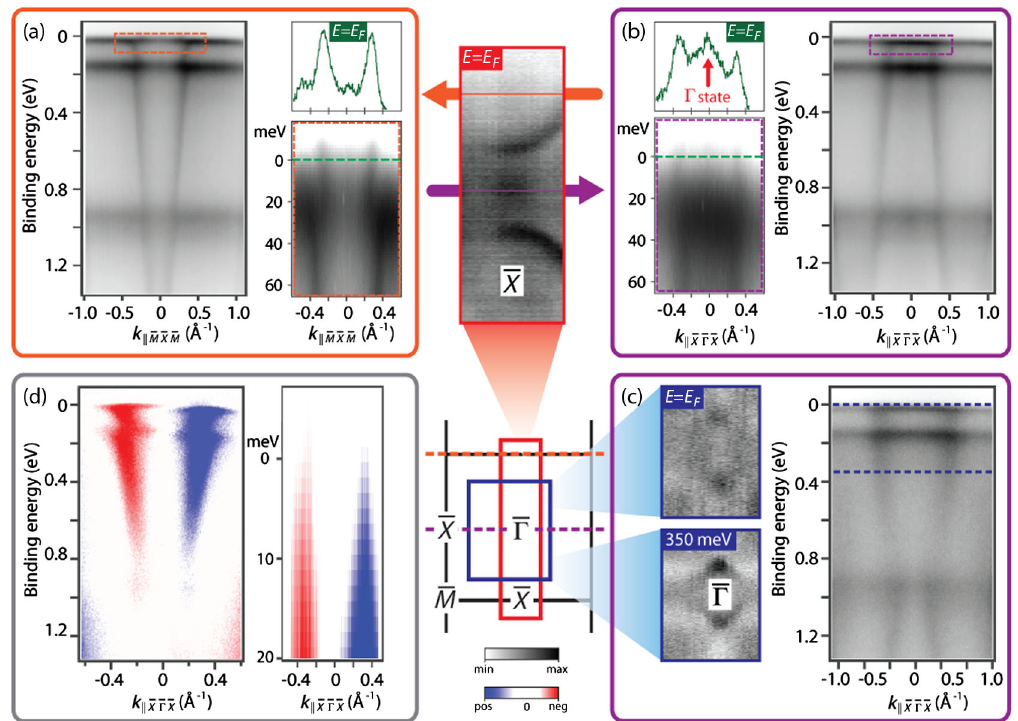
FIG. 3. Energy dispersion and dichroic signature of the X state and identification of an additional (cid:1) -state feature. (a),(b) Data recorded for k z ¼ 6 (cid:2)=a ( h(cid:1) ¼ 70 eV ) for the k -space cuts along the MXM and X (cid:1) X high-symmetry directions as indicated by the color-coded arrows underlying the Fermi-surface map in between the panels (integrated over (cid:3) 5 meV ). In each case, a zoom of the dashed region is included, as is a momentum-distribution line cut in green for E ¼ E F . In (a), the zoom panel clearly shows the X states crossing E F , and the same states seen as the outer two features in (b) are joined by an enigmatic, third feature centered on the zone center dubbed the (cid:1) state. (c) Data along the same direction as that in (b) but now recorded for k z ¼ 4 : 5 (cid:2)=a ( h(cid:1) ¼ 34 eV ). It is evident that these Sm 5 d -dominated states now have an inverted dispersion with respect to (b). Plus, both the Fermi surface and the (cid:2)(cid:1) 350-meV energy contour (both integrated over (cid:3) 10 meV ) possess significant intensity around the point, rather than centered on (cid:2) X the point. A schematic of the surface Brillouin zone is added between (c) and (d), showing the color-coded k -space coverage of the constant-energy surfaces and the k -space trajectories, giving the E ð k Þ images as dashed lines. Finally, (d) illustrates the dichroic signature of the Sm 5 d -related bands, shown for different binding-energy regimes and k z values. Plotted is the difference in ARPES intensity between data recorded using left or right circular light. It is clear that this dichroic signal has the same sign at all energies below 1 eV. In particular, the fact that the same dichroic response is seen for high binding energy (left panel, h(cid:1) ¼ 34 eV , k z ¼ ¼ 2 (cid:2)=a ) shows that the states that give rise to the 4 : 5 (cid:2)=a ) and for the 20 meV closest to the Fermi level (right panel, h(cid:1) ¼ 21 eV , k z (cid:2) X elliptical Fermi surfaces around the points are no different than those that make up the large-scale 5 d -related dispersive features pointed out in Fig.